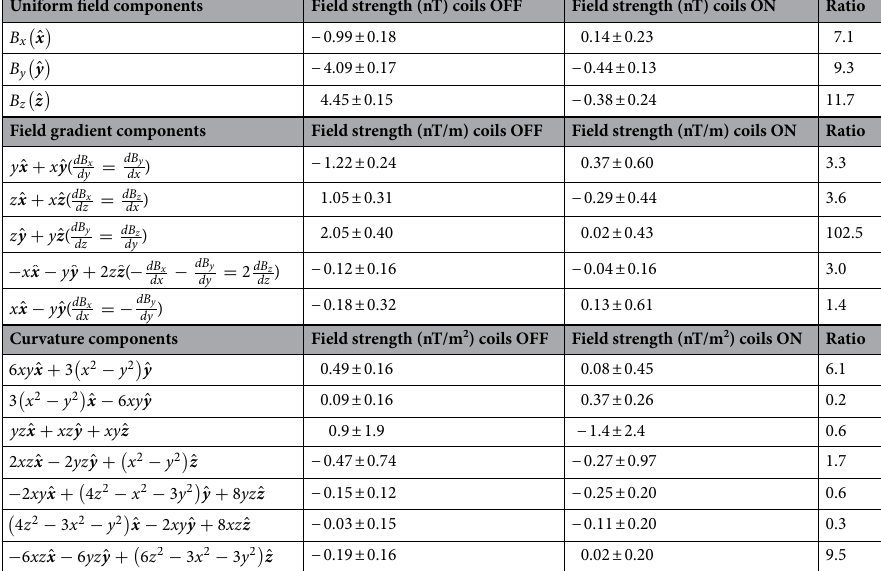
Table 2. Model fit coefficients before and after nulling for fifteen field components in the spherical harmonic model. Values quoted are the mean and standard deviation over eight repeat measurements. ˆ x , ˆ y , ˆ z denote the Cartesian unit